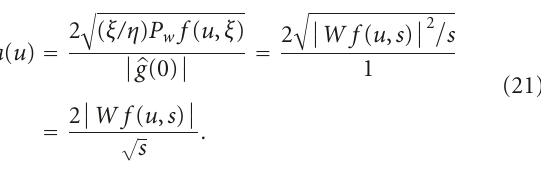
Figure 5: Frequency plot of (15) for two CMWs at scales S 1 and S 2 ,